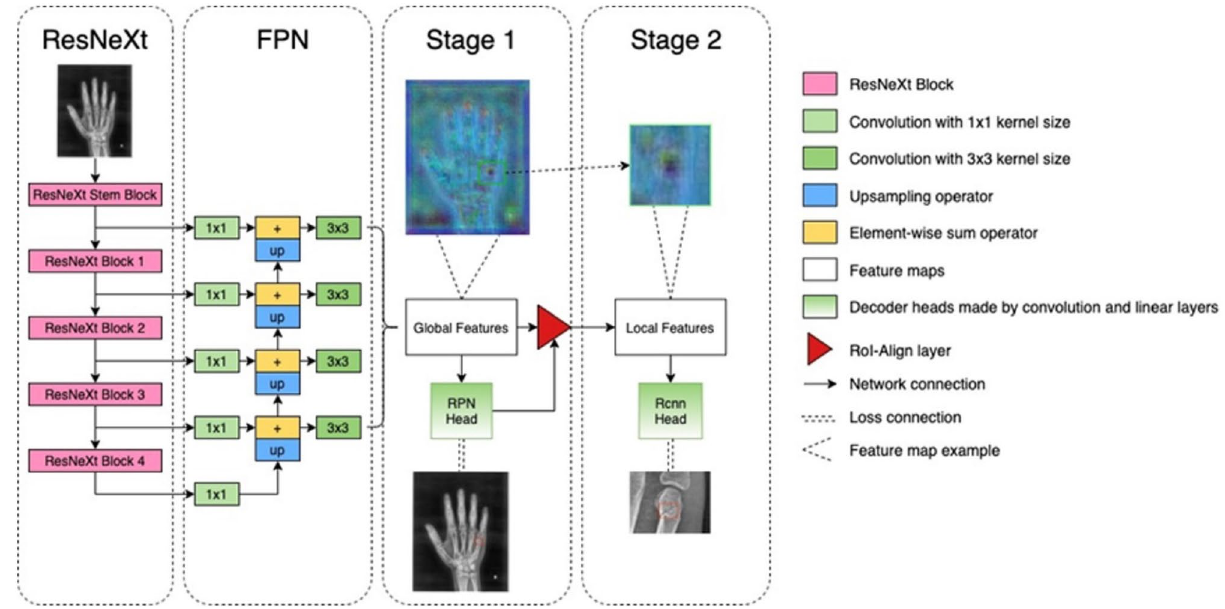
Figure 5. Object detection architecture on fractures